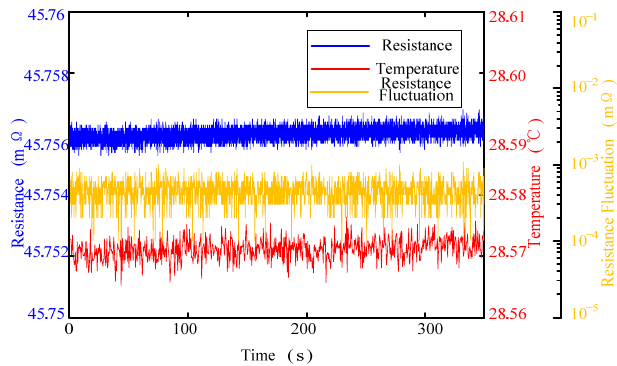
Figure 7. Static contact resistance and resistance fluctuation at 28.57 °C.